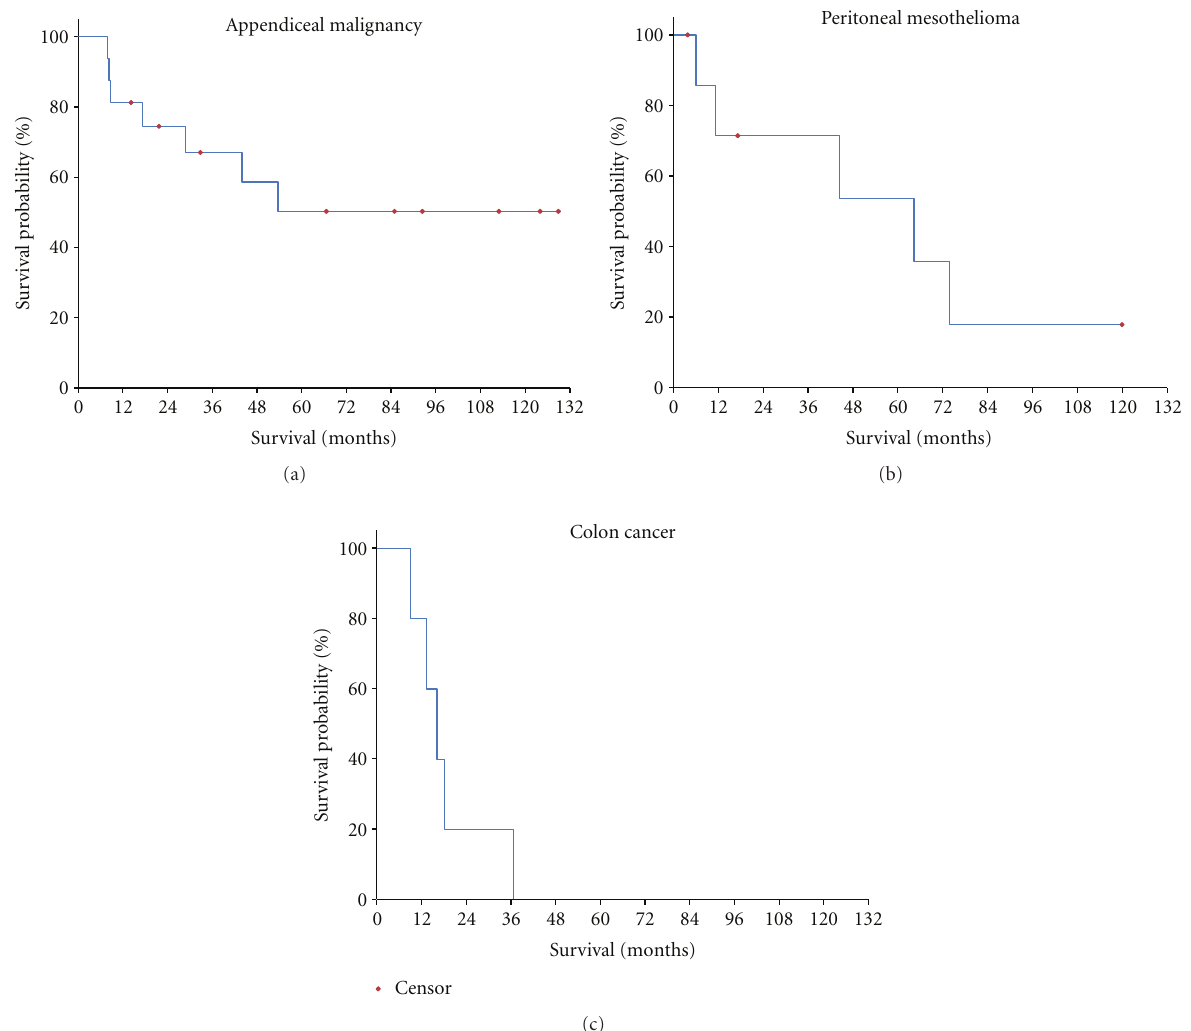
Figure 5: Survival for 29 patients who had a resection of the diaphragm as part of the cytoreductive surgical procedure combined with hyperthermic intraoperative thoracoabdominal chemotherapy (HITAC). (a) appendiceal malignancy ( N = 16), (b) peritoneal mesothelioma ( N = 8), and (c) colon cancer ( N =